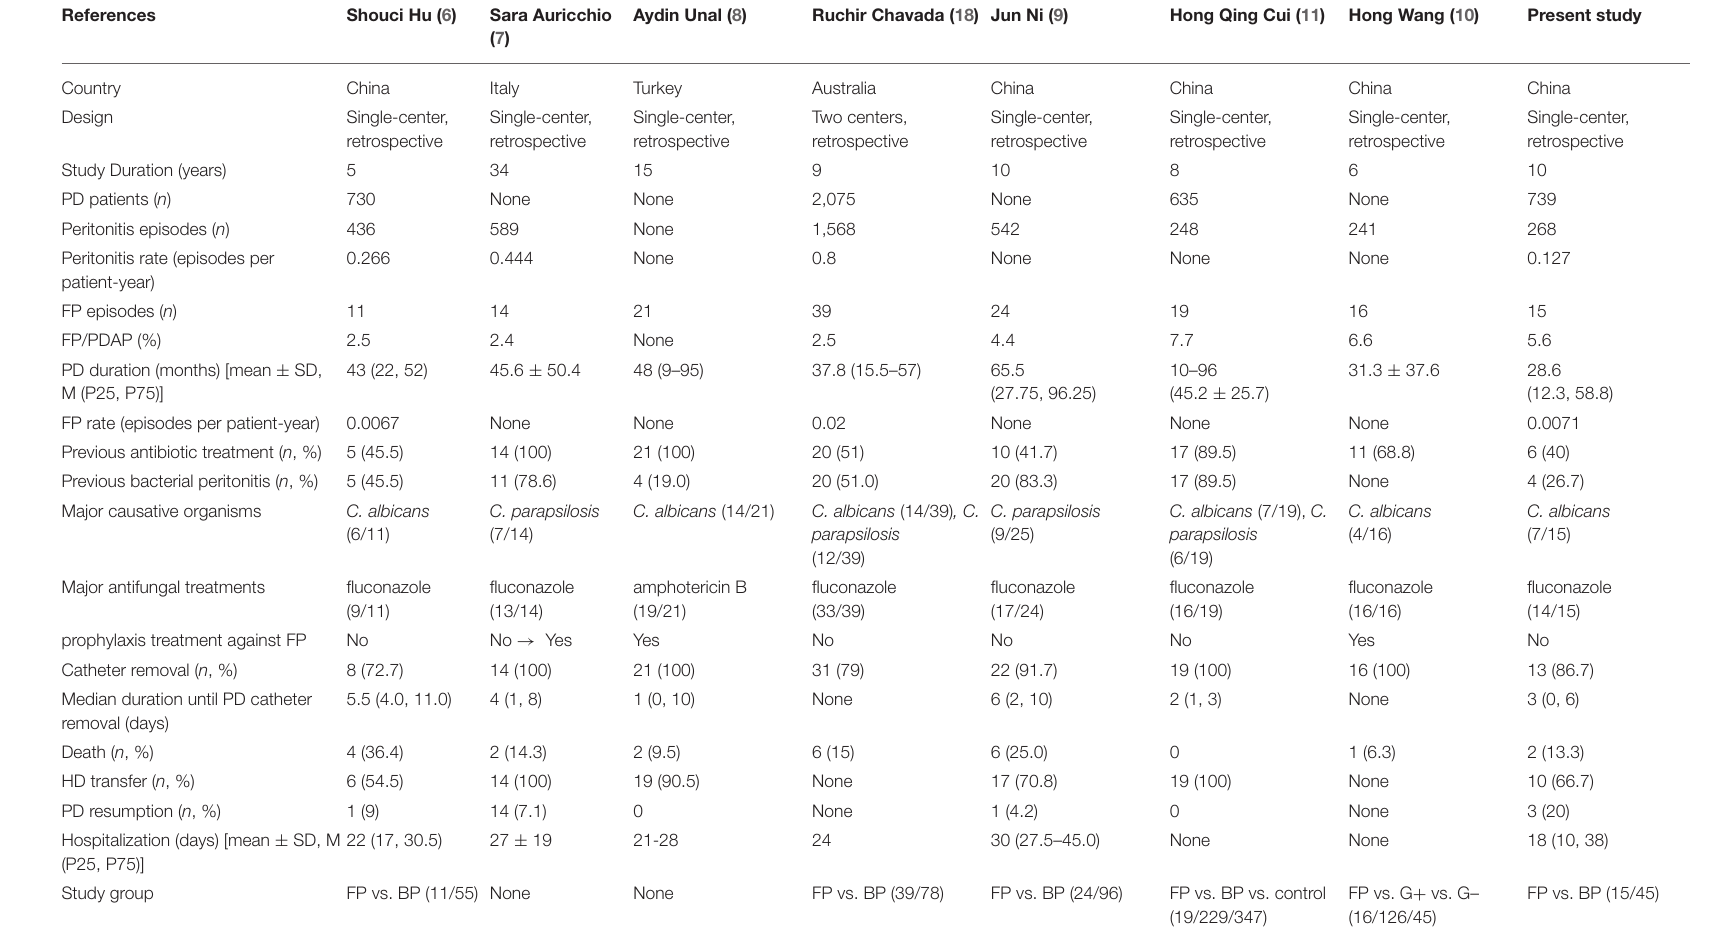
TABLE 6 | Previous and present studies focusing on fungal peritonitis in peritoneal